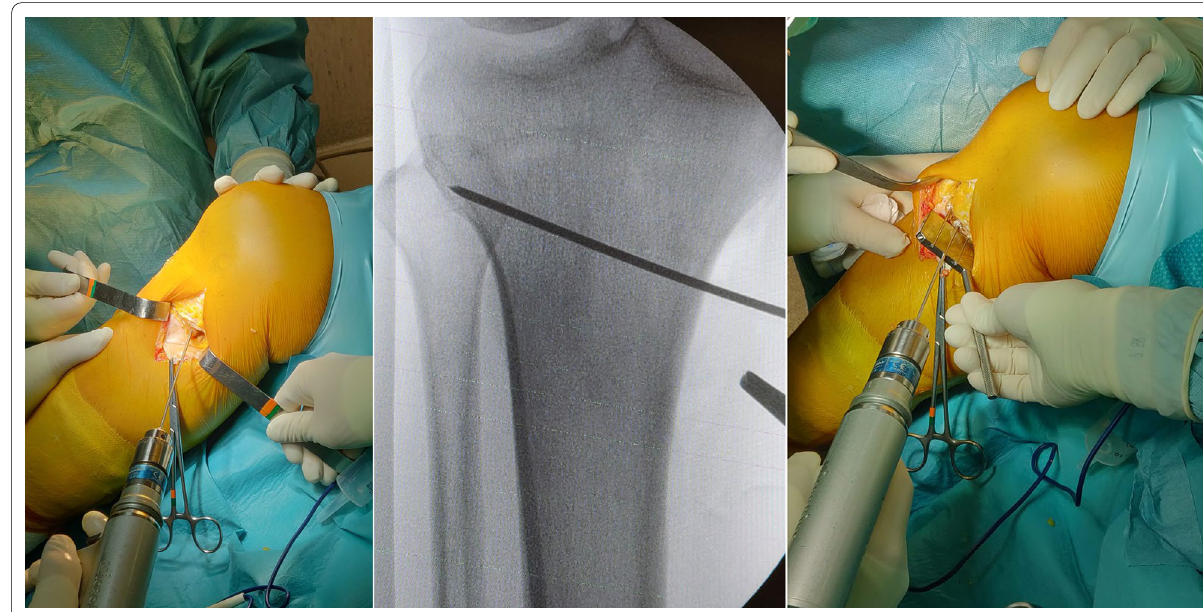
Fig. 2 Intraoperative findings and fluoroscopic imaging of the first guide wire drilled through the proximal right tibia from medial to lateral directed 20° upwards. The first wire is advanced, under fluoroscopic guidance, toward the superior part of the fibular head. On the right is shown the positioning of the two additional parallel wires with the assistance of a self-made guiding